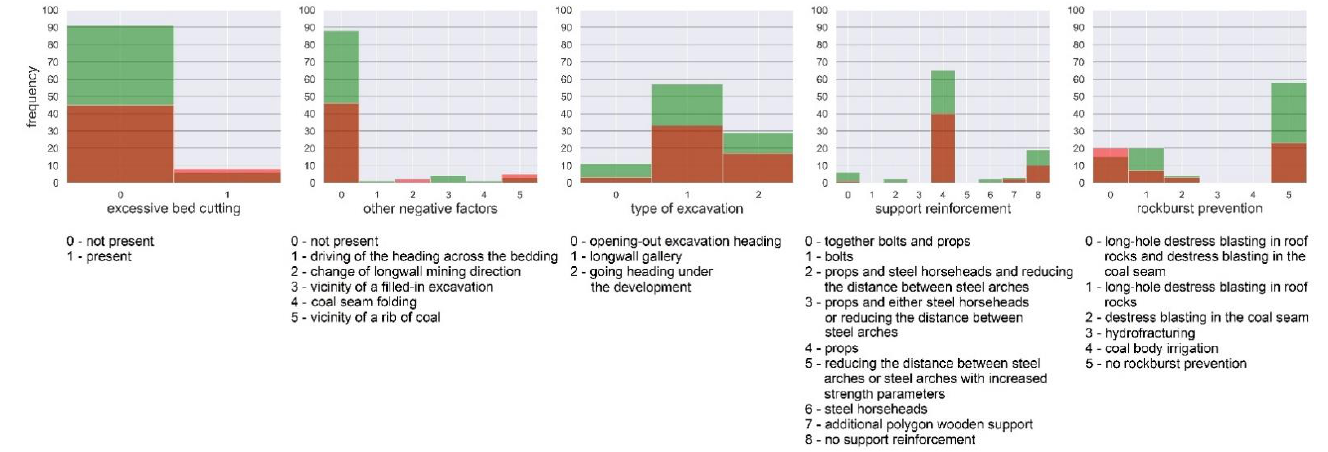
Figure A2. Histograms of selected indicators with text value influencing the occurrence of rockbursts.